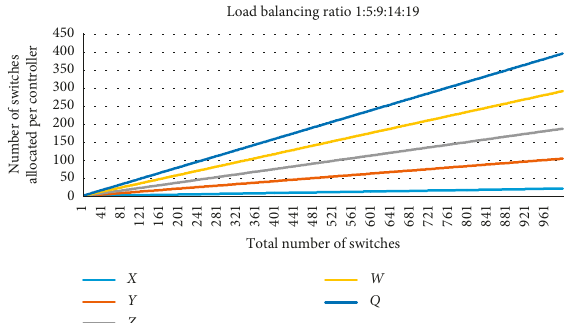
Figure 16: Load balancing for five slave controllers with ratios 1 :5: